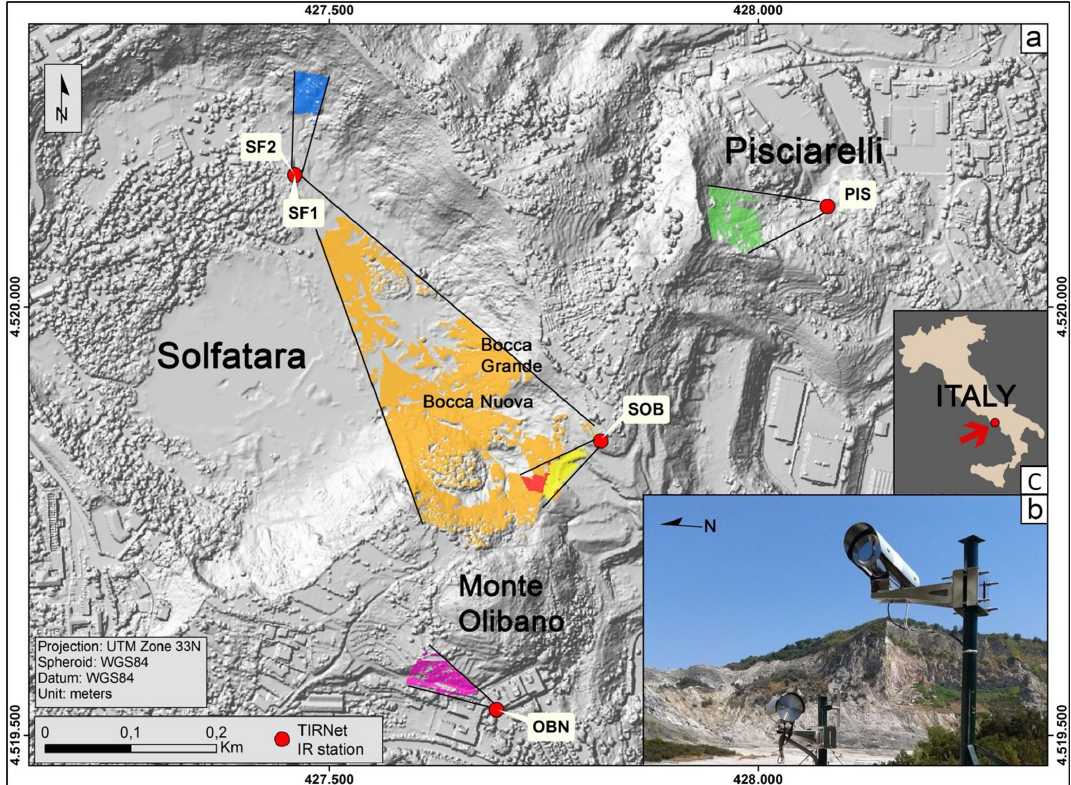
Figure 1. (a) Digital Terrain Model (DTM) of Solfatara crater (Vilardo et al., 2013) with location of TIRNet stations (red dots) and studied framed areas mapped in GIS environment by using Field of View (FoV) values of infrared sensors. The area framed by SF1 is highlighted in orange, SF2 in blue, PIS in green, OBN in magenta, SOB in yellow and the common area between SF1 and SOB in red. (b) Picture of the TIRNet station site inside Solfatara crater (SF1 and SF2), composed of two TIR cameras pointing towards two different anomaly areas. The photo contained in Fig. 1 was taken by authors. (c) The position of the study area on the Italian territory is indicated by a red